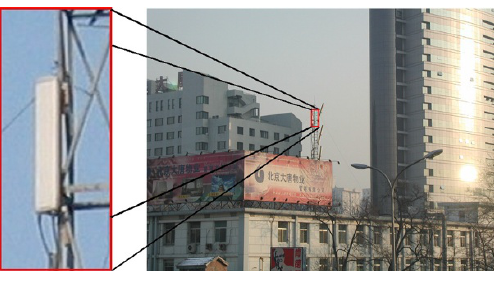
Figure 9: Modified Ericsson RBS 3202 hardware integrating mul- tiuser PIC functionality.